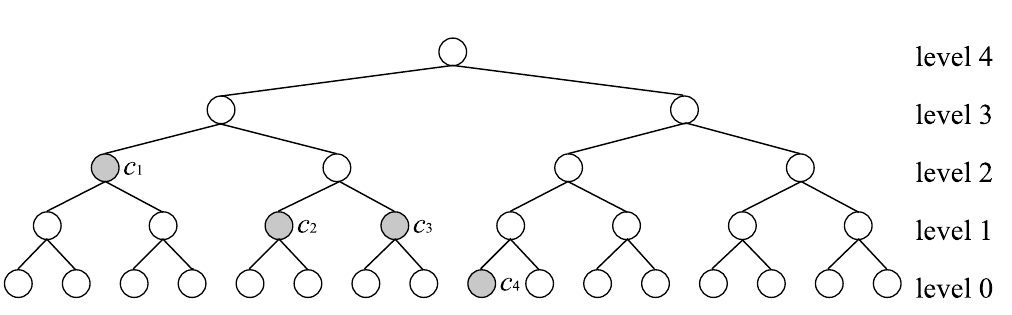
Figure 1. An OVSF code tree of hight